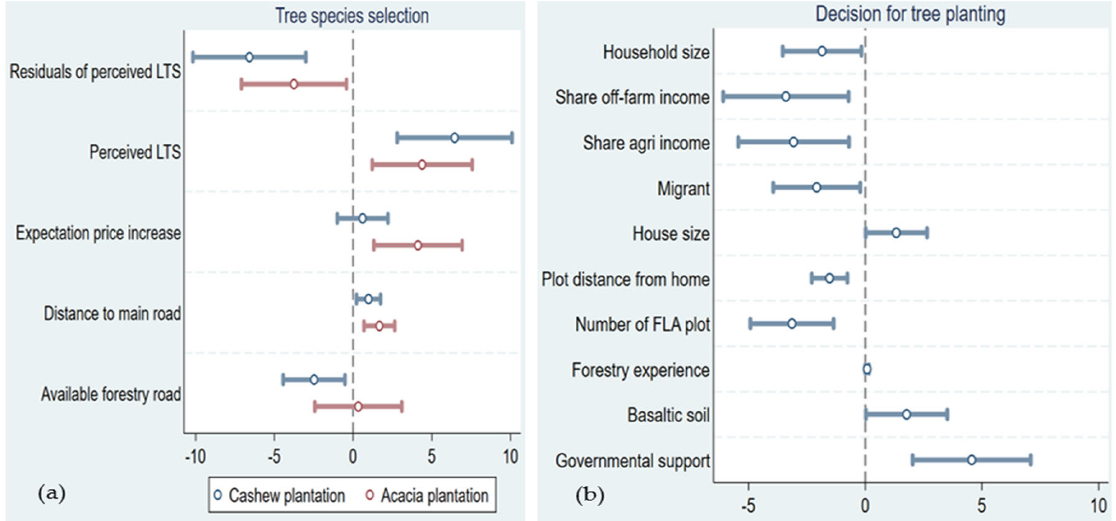
Figure 3. Impact of perceived LTS on land ‐ use investment ( a ) Effects of LTS perceptions and other factors on species choices; ( b ) Effects of other factors on tree planting (Bar length indicates parameter confidence interval).